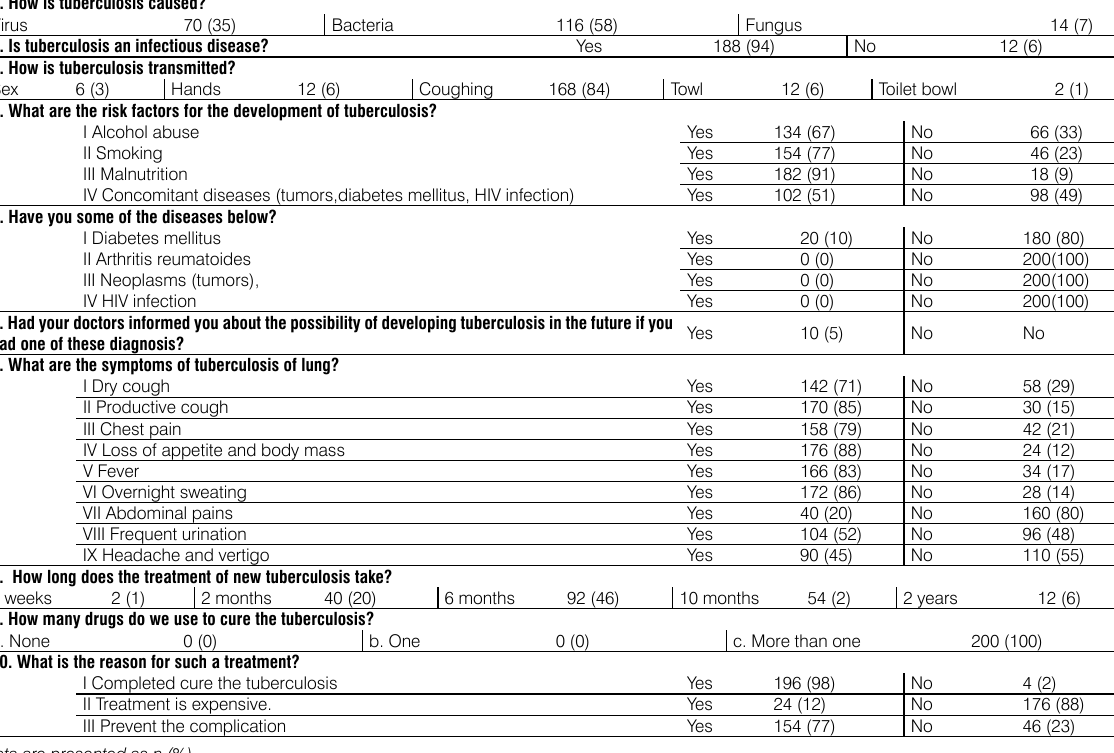
Table 1. Answers to the questionnaire no. 1 (n, %).